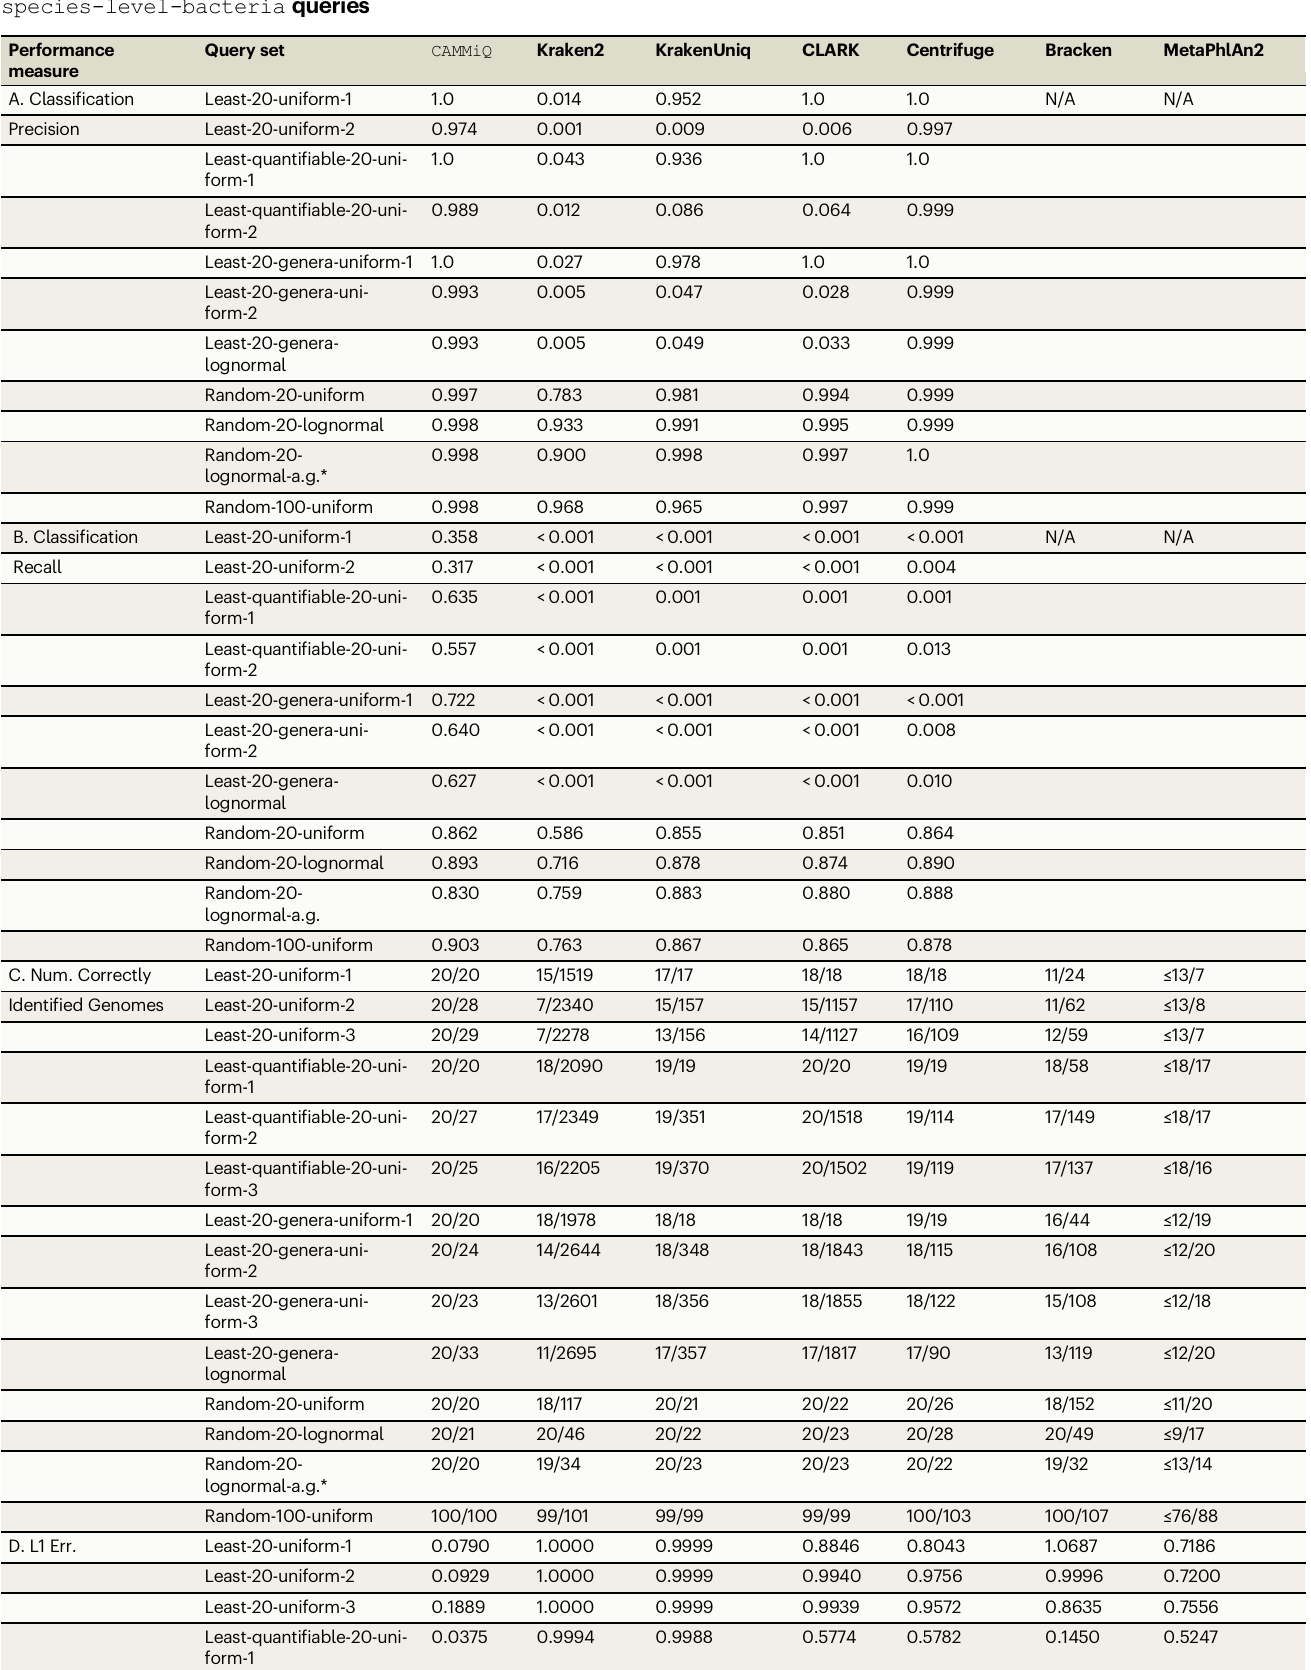
Table 3 | Performance evaluation of CAMMiQ , Kraken2, KrakenUniq, CLARK, Centrifuge, Bracken and MetaPhlAn2 on the 14 species-level-bacteria